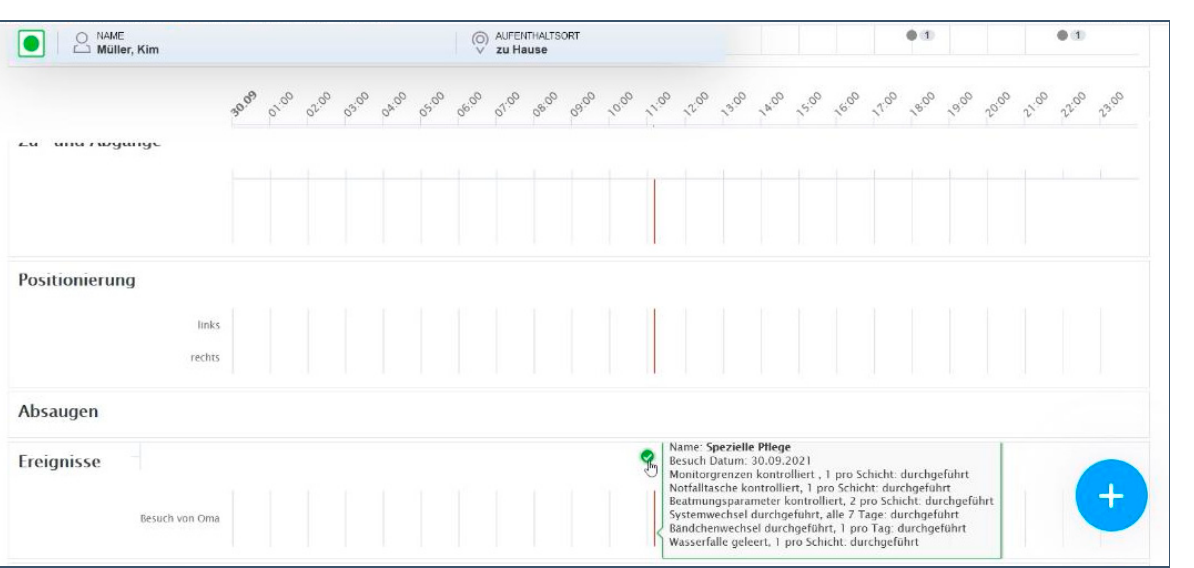
Figure 4. Mouseover field for documenting nursing activities in the patient chart view.